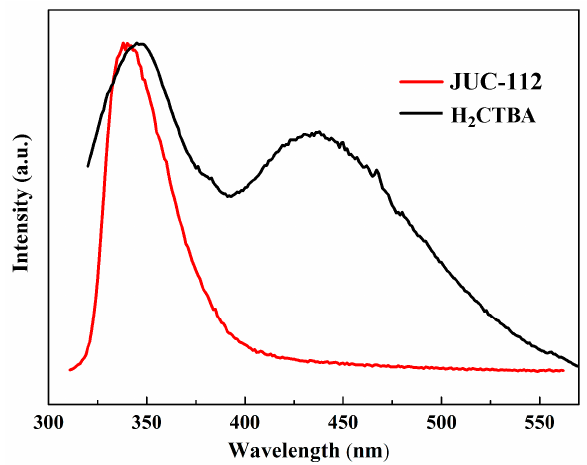
Figure 8. Solid-state luminescence emission spectra of JUC-112 and the ligand at room temperature.